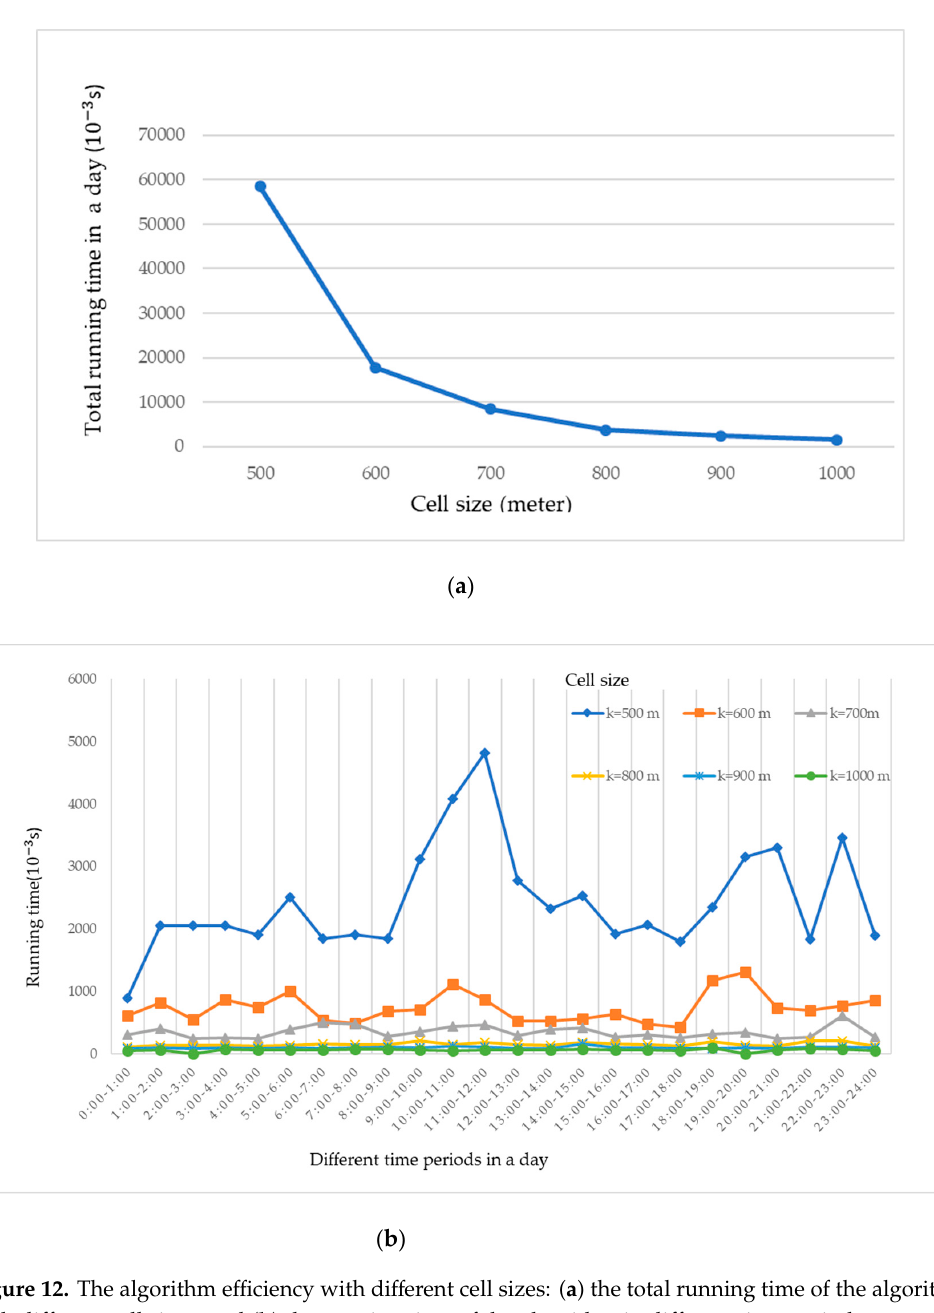
Figure 12. The algorithm e ffi ciency with di ff erent cell sizes: ( a ) the total running time of the algorithm with di ff erent cell sizes, and ( b ) the running time of the algorithm in di ff erent time